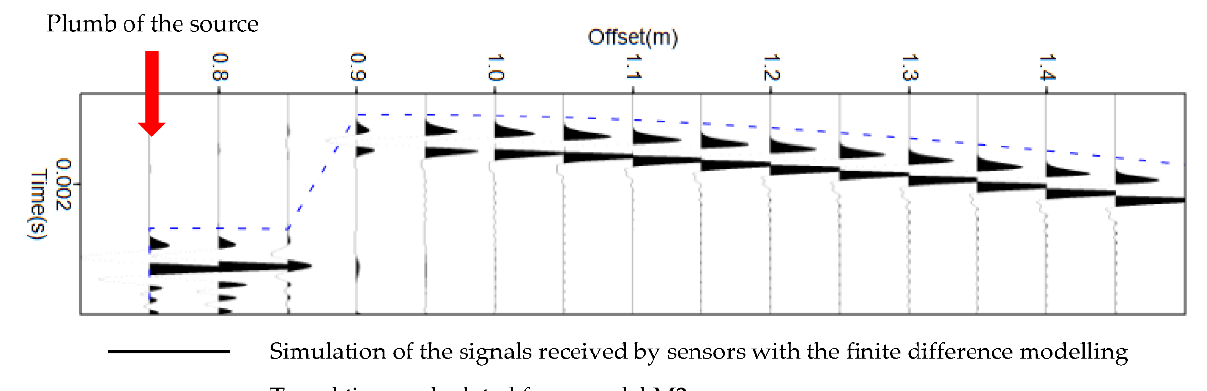
Figure 17. Seismograms obtained by full wavefield propagation using the finite differences method in the physical velocity model presented in Figure 16. The horizontal axis indicates the position of the sensors. The red arrow indicates the sensors located at the plumb of the source. The theoretical travel times calculated in the same model (M2) by the method proposed in Section 3.1 are plotted with a blue dashed line to assess the good agreement. The transmitted signal is considered as the same emitted Ricker function (Figure 7a).